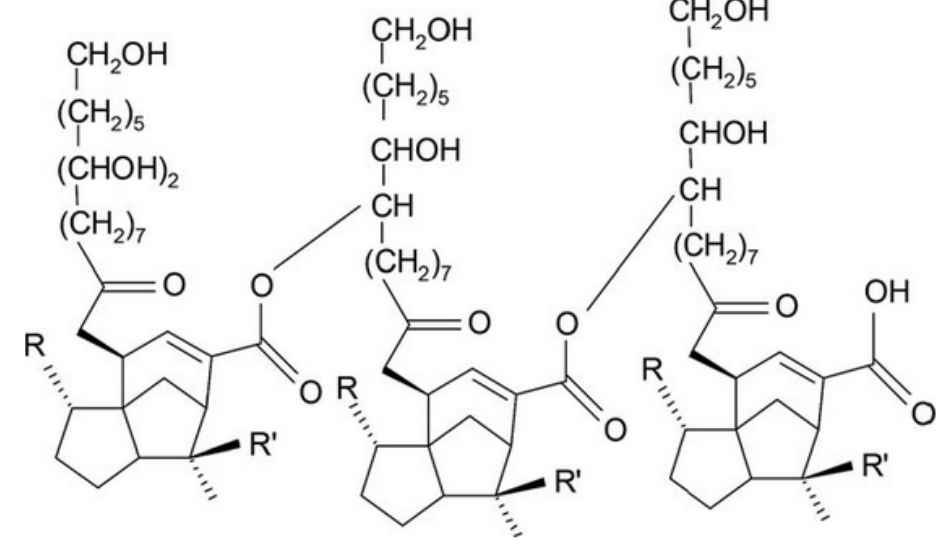
Figure 8. Represents the chemical structure of Shellac